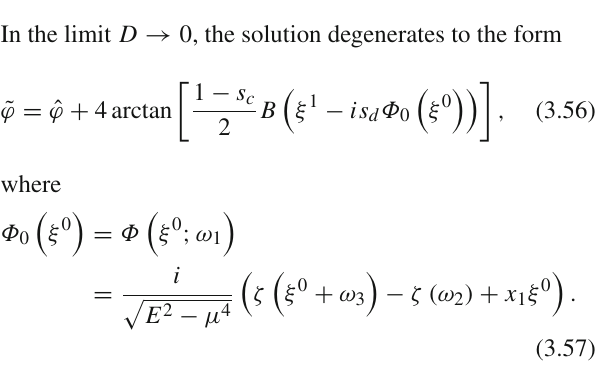
a periodic, translationally invariant solution. It turns out